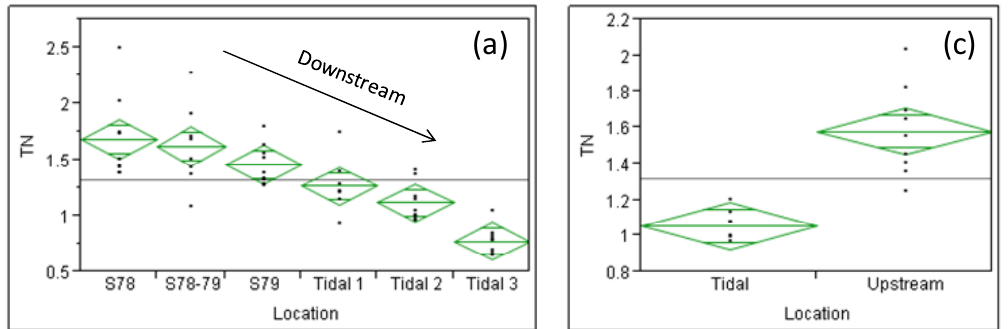
Figure 8. ( a ) Total N concentrations (mg/L) along the Caloosahatchee River. ( b ) Total P concentrations (mg/L) along the Caloosahatchee River. ( c ) Comparisons between